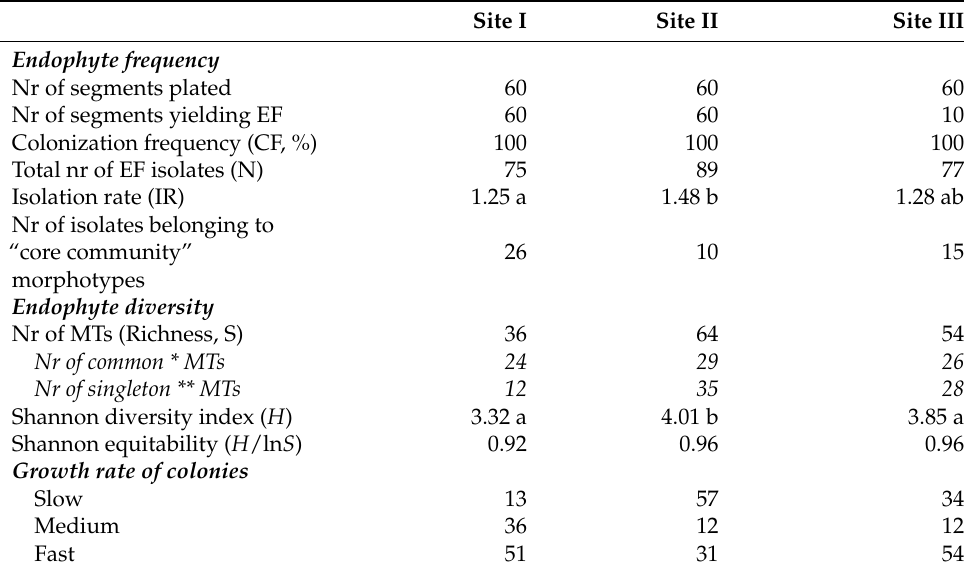
Table 1. Summary of the results for endophyte frequency and diversity, based on analysis of bark and young xylem samples collected from elm trees growing at the three sites where vaccinations were ongoing at the time of sampling (Site I), where vaccinations had ceased (Site II) and where trees had not been vaccinated (Site III). Mean values with different letters are significantly different ( α = 0.05). EF = endophyte, MT = morphotaxa. Site I Site II Site